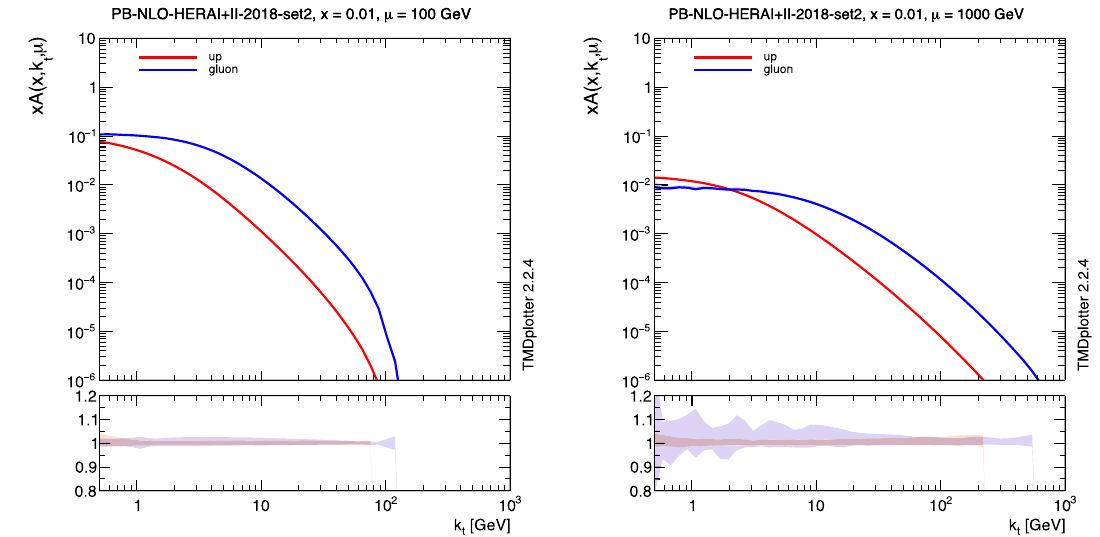
Fig. 1 TMD parton density distributions for up quarks and gluons of PB-NLO-2018-Set 2 as a function of k T at μ = 100 and 1000 GeV and x = 0 . 01. In the lower panels show the full uncertainty of the TMD PDFs, as obtained from the fits